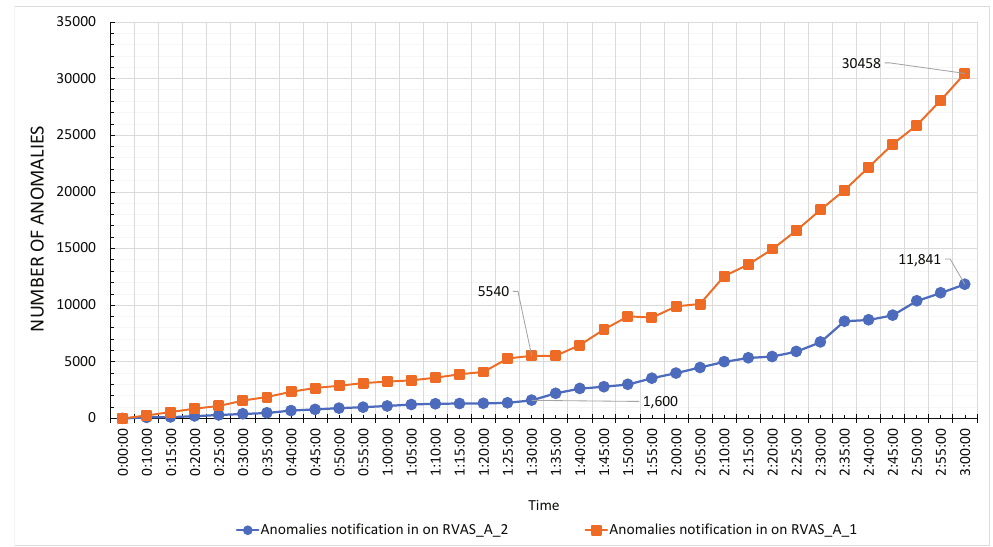
Figure 22. Total number of anomalies produced by Face detection and Activity